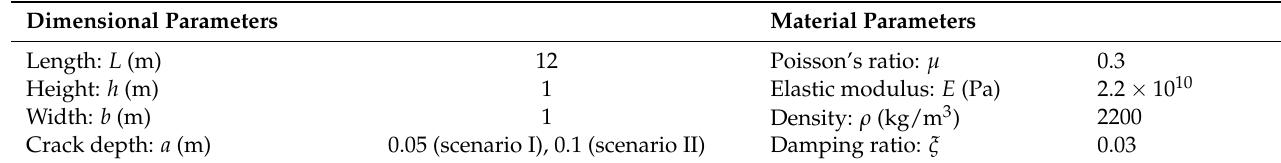
Table 1. Relevant parameters of the cracked cantilever beam.